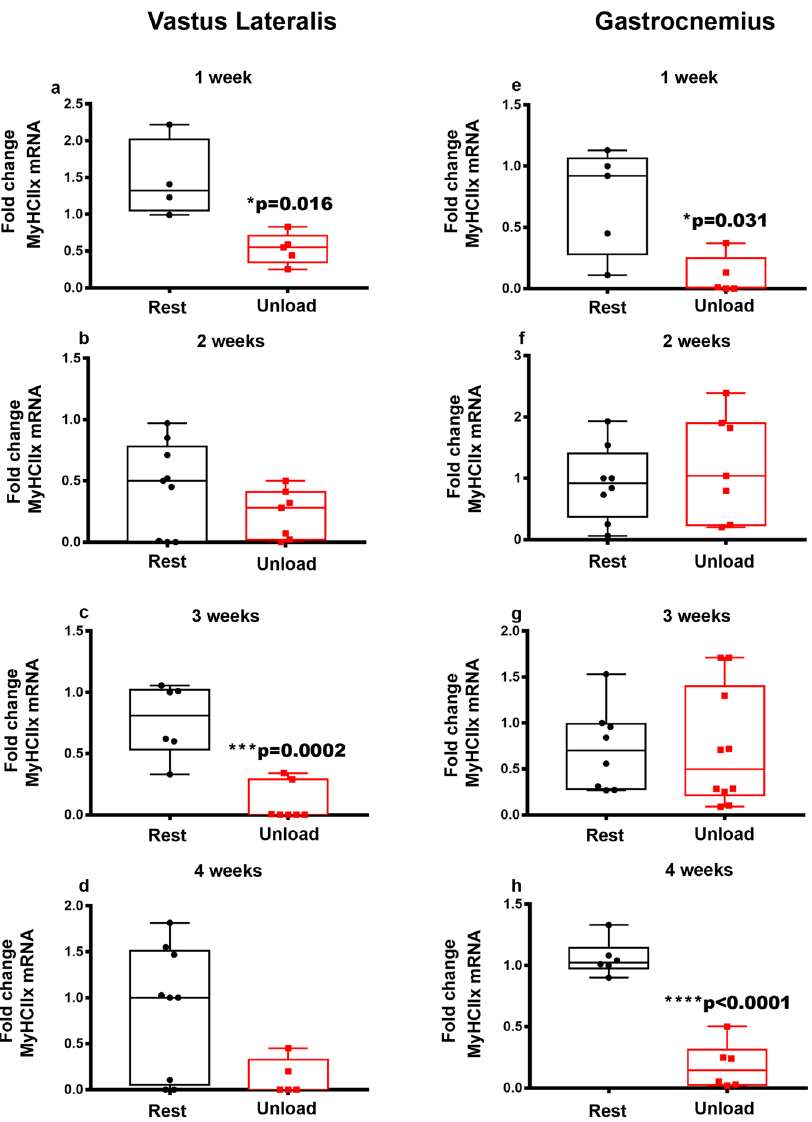
Fig. 3 Effect of unloading on MyHCIIx myosin expression in Vastus Lateralis and Gastrocnemius. Quantitative PCR (qPCR) showing mRNA expression levels of MyHCIIx in Vastus Lateralis ( a – d ), and Gastrocnemius ( e – h ) muscles of control mice kept in resting condition (Rest) and HU mice (Unload) at time points 1-2-3 and 4 weeks. Analysis showed a down-regulation of MyHCIIx at 1 week of suspension in both Vastus Lateralis ( a ) and Gastrocnemius ( e ) muscles. The decrease of MyHCIIx was also observed at 3 and 4 weeks of suspension in Vastus Lateralis ( c ) and Gastrocnemius ( h ), respectively. Shapiro-Wilk test and Mann-Whitney test were performed. Data are presented as box-and-whisker with median and interquartile ranges, from max to min, with all data points shown. * p < 0.05, *** p < 0.001, **** p < 0.0001 vs